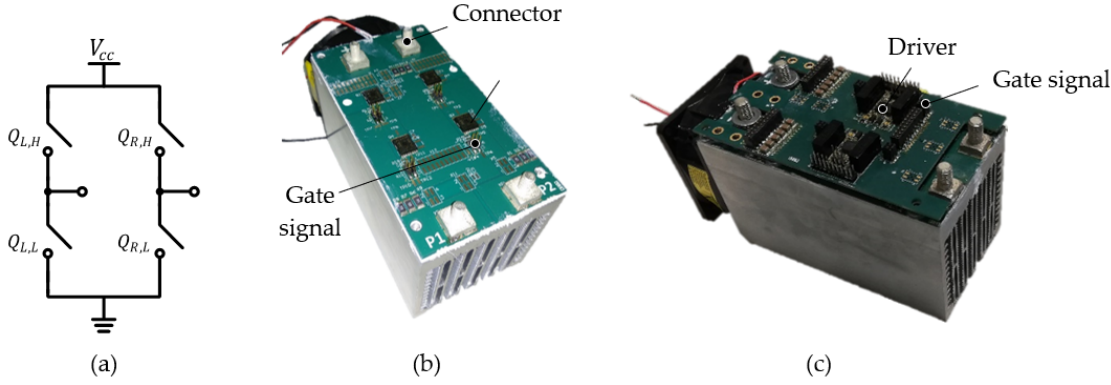
Figure 9. Assembled full-bridge prototype. ( a ) High level schematic. ( b ) Power layer. ( c ) Driver layer.